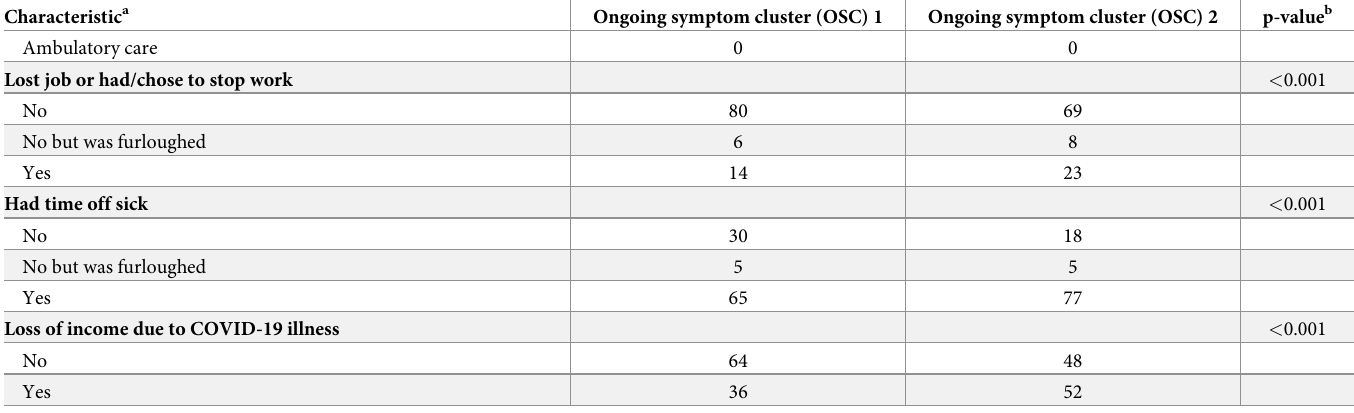
Multivariate fully adjusted analysis showed that being female (OR = 2.0, 95% confidence interval (CI) 1.2, 3.4), poor baseline health (OR = 3.4, 95% CI 1.2, 9.8), being a member of ACS2 (OR = 2.5, 95% CI 1.7, 3.5), a higher number of acute symptoms related to different organ systems (OR = 1.2, 95% CI 1.04, 1.31) were positively associated with membership of the more severe OCS2 cluster. Older age ( > 60 years) (OR = 0.35, 95% CI 0.19, 0.66), higher income (OR = 0.85 per increase in income category, 95% CI 0.75, 0.95), and sufficient rest in the first two weeks of the illness (OR = 0.68, 95% CI 0.46, 0.99) seemed to be protective against OCS2. OSC2 membership was not related to the duration since onset of acute symptoms (Fig